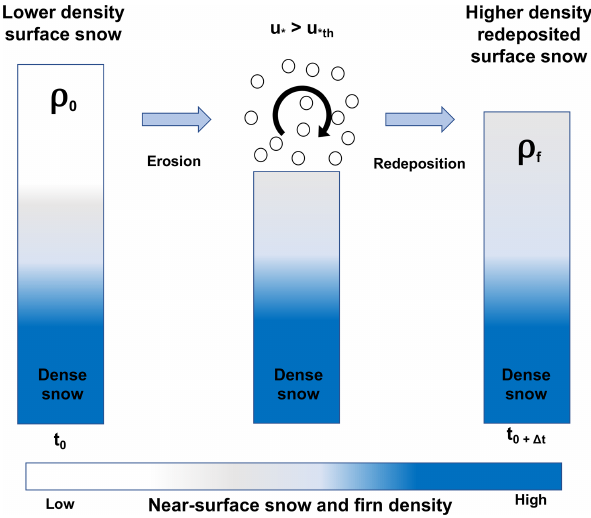
Figure 1. Schematic of SNOWPACK drifting-snow compaction. When the friction velocity exceeds the snow threshold friction ve- locity ( u ∗ > u ∗ th ), initial lower-density surface snow (left) is eroded by the wind, mobilized above the snow surface (middle), and then redeposited with a higher density (right).